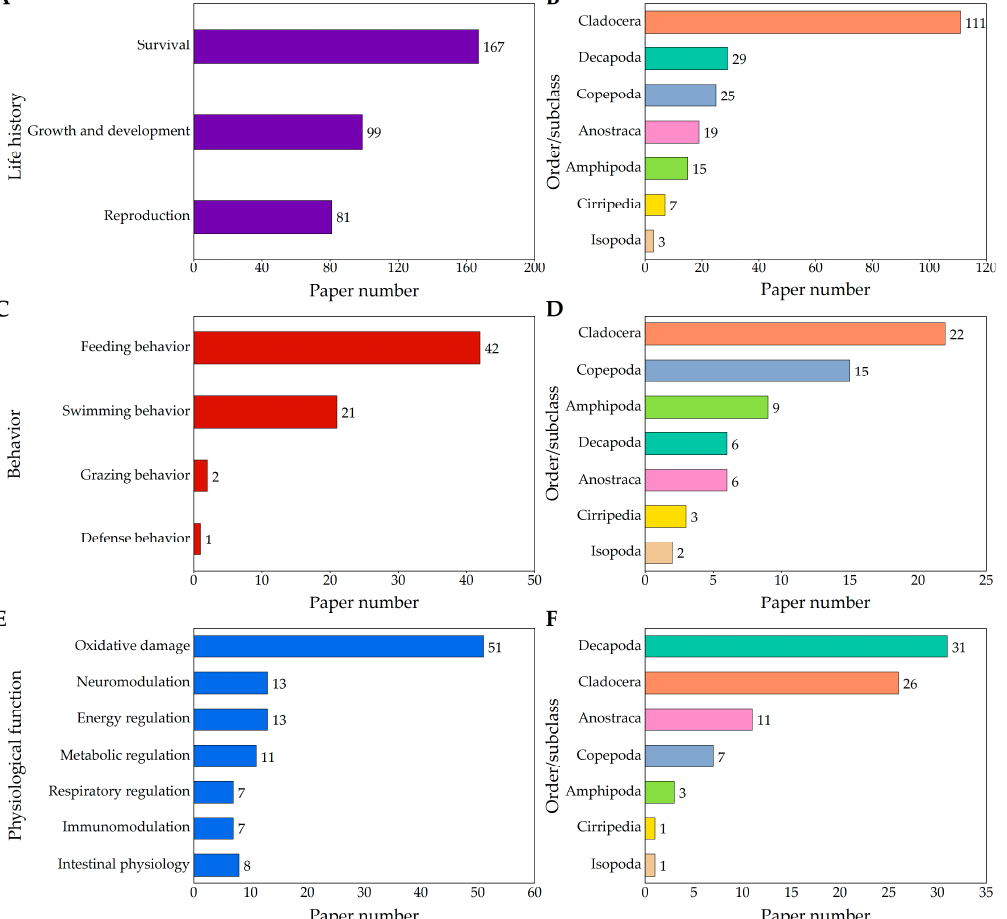
Figure 2. The number of papers on the effects of microplastics on the life history, behavior and physiological function of aquatic crustacean. The number of papers examining the life history, behavior and physiological function of aquatic crustacean impacted by microplastics are shown in ( A , C , E ), respectively. The number of papers on aquatic species involved in the life history, behavior and physiological function of aquatic crustacean are shown in ( B , D , F ),